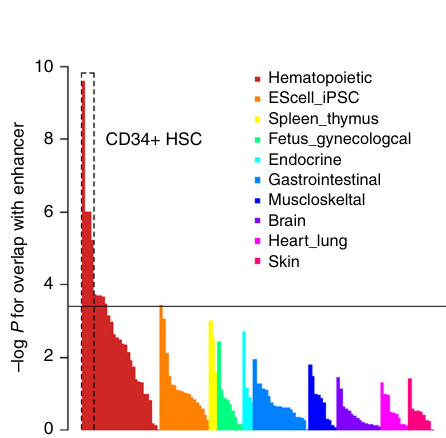
Fig. 7). Enhancer marks in embryonic stem cells (ES cells) or